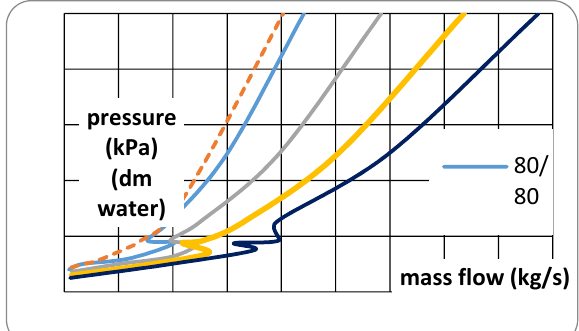
Fig. 4-3. Phase interface, Δ p = 2 kPa, 2x enlarged outlet area.